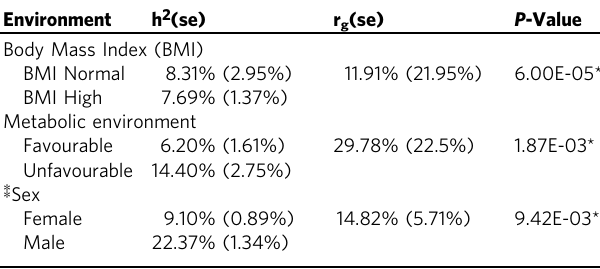
Table 5 GREML based GxE interaction estimates for incident hormone-sensitive cancers using baseline measured